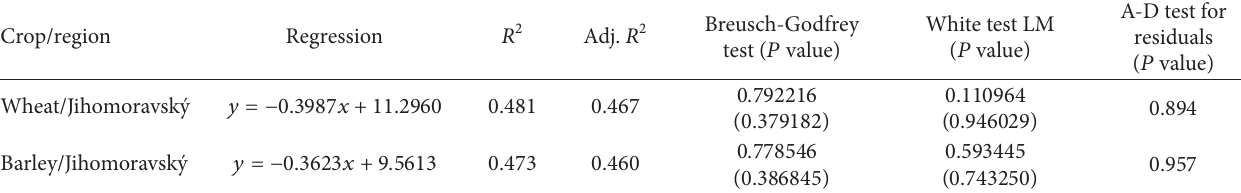
Table 3: Results of the regression analysis.